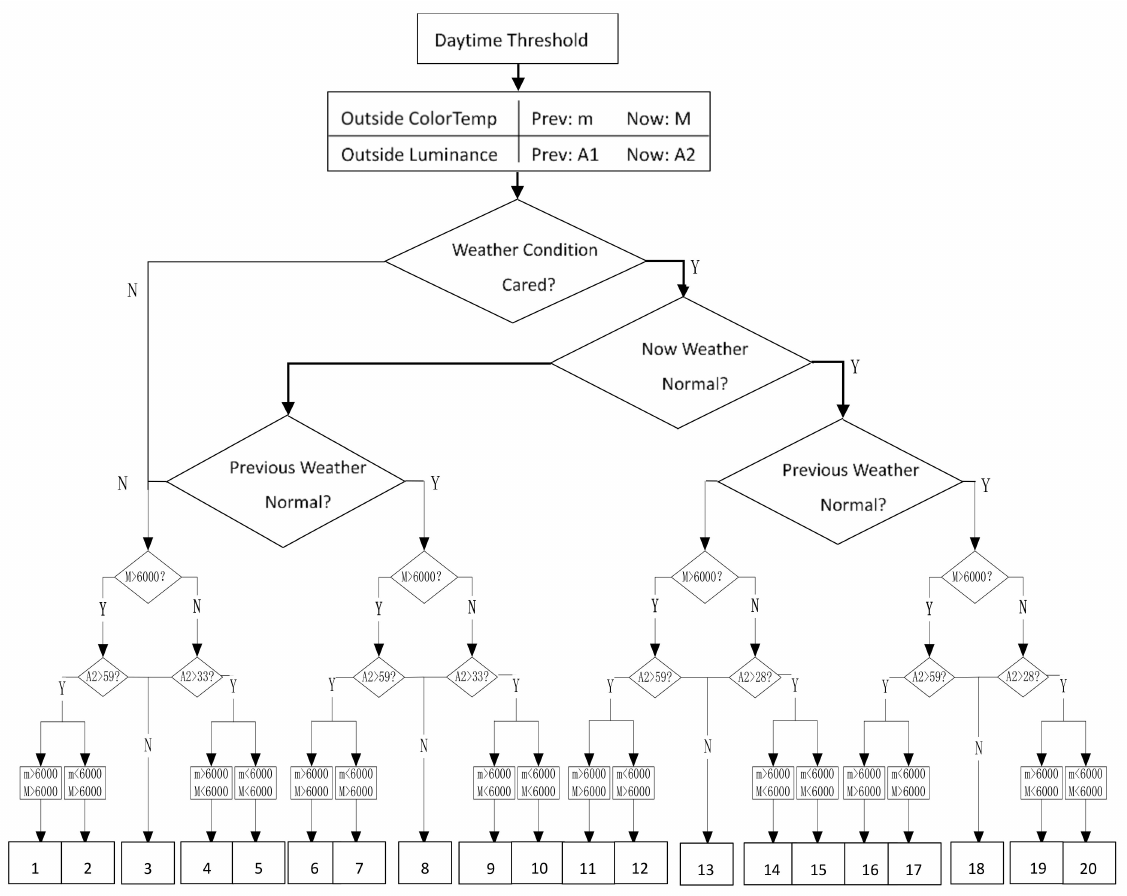
Figure 8. Flowchart of Lighting APP at 80 km/h.